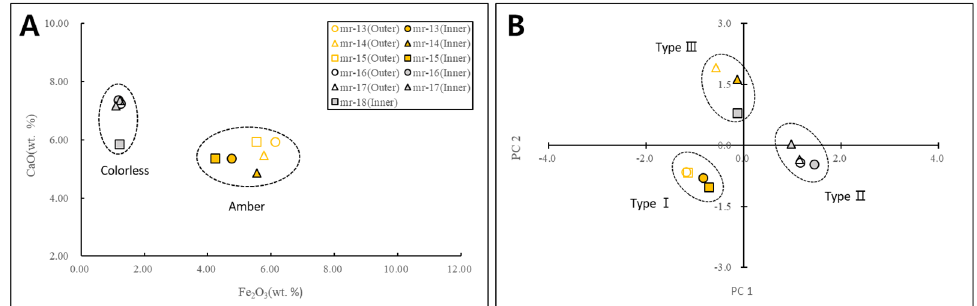
Figure 4. Composition comparison of silver foil glass beads; ( A ): Fe 2 O 3 vs. CaO, ( B ): Principal component analysis.